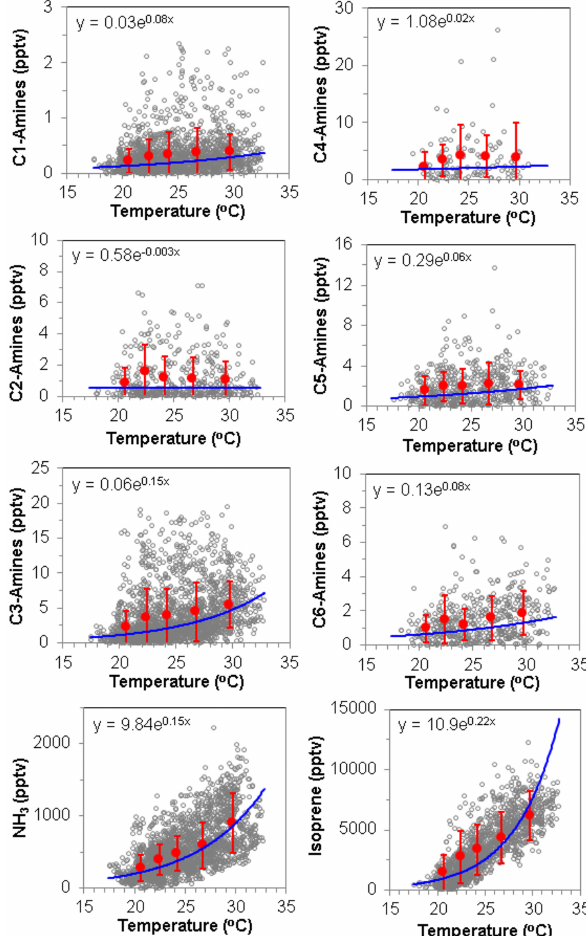
Figure 4. Temperature dependence of amines, NH 3 and isoprene for the entire SOAS campaign. Gray dots show the measurement data and blue lines show exponential fitting of the data. Red circles and vertical lines show the mean and one standard deviation of con- centrations of these chemical species, with each bin representing 20 percentile of temperature